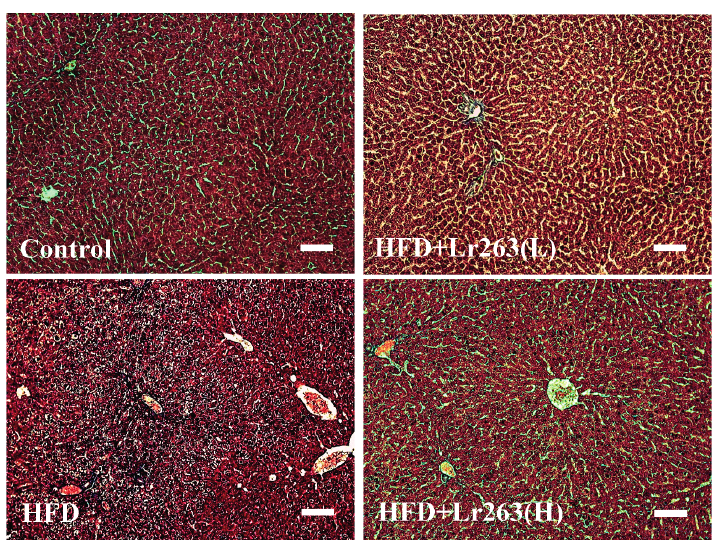
Figure 2. Fibrosis assessments. Cirrhosis was assessed using Massion’s trichrome (MS) staining assay to indicate the collagen accumulation (by the blue color) in liver tissue slides. The bar length is 100 μ